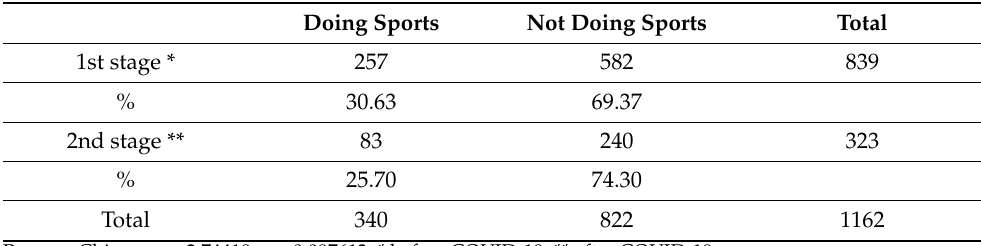
Table 4. Pupils’ answers to the question “How many hours a week do you do sports outside PE at school?” before and after situation caused by COVID-19. Doing Sports